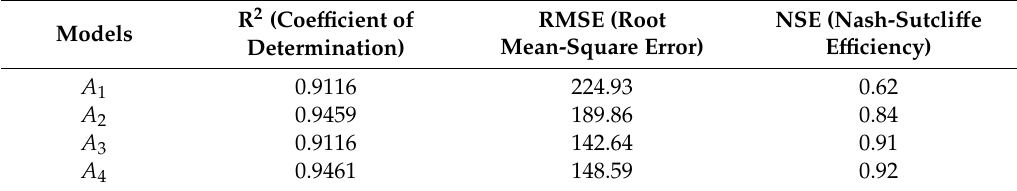
Figure 7. Comparison between the predicted and measured value of water area. Table 4. Performance comparison of A 1 , A 2 , A 3 , and A 4 models.